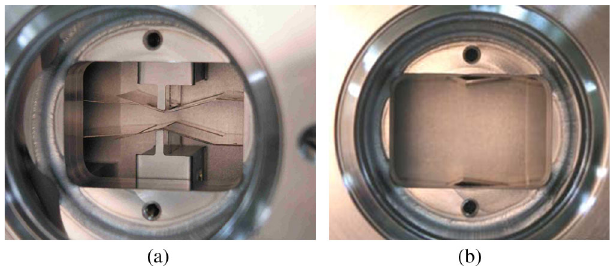
FIG. 11. Photograph of the beam pipe adaptor. (a) Beam pipe side with circular cross section. (b) Monitor side with square cross